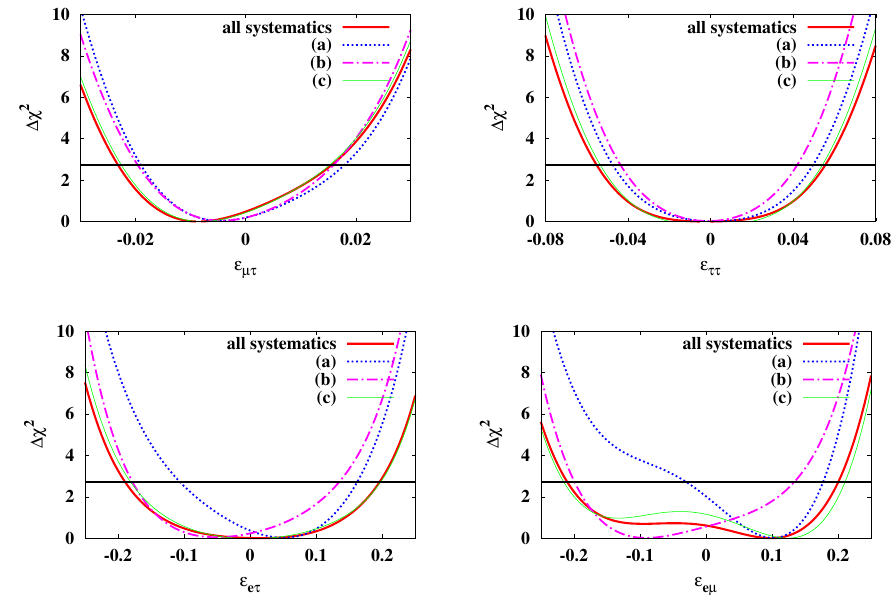
Figure 9 . Values of (cid:1) (cid:31) 2 (NO) for the NSI models with non-zero values of (cid:15) (cid:22)(cid:28) (upper left), (cid:15) (cid:28)(cid:28) (upper right), (cid:15) e(cid:28) (lower left) and (cid:15) e(cid:22) (lower right) obtained in the analyses with all systematic un- certainties included (red thick solid line) in comparison with those obtained with (a) (cid:12)xed nuisance parameters related to atmospheric neutrino (cid:13)ux (blue dotted line), (b) (cid:12)xed nuisance parameters related to the experimental uncertainties (magenta dashed-dotted line) and (c) (cid:12)xed nuisance pa- rameters related to normalization of di(cid:11)erent contributions to expected number of events (green thin solid